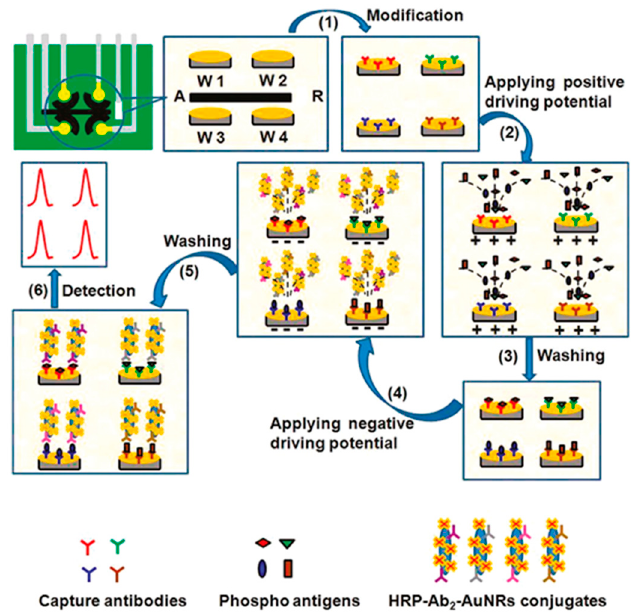
Figure 1. Multiplexed electrochemical immunoplatform for the simultaneous determination of phosphorylated p53 at Ser392 (phospho-p53 392 ), Ser15 (phospho-p53 15 ), Ser46 (phospho-p53 46 ), and total p53 using electric field-driving and multi-enzyme labeling amplification. Reprinted from Ref. [8] with permission.